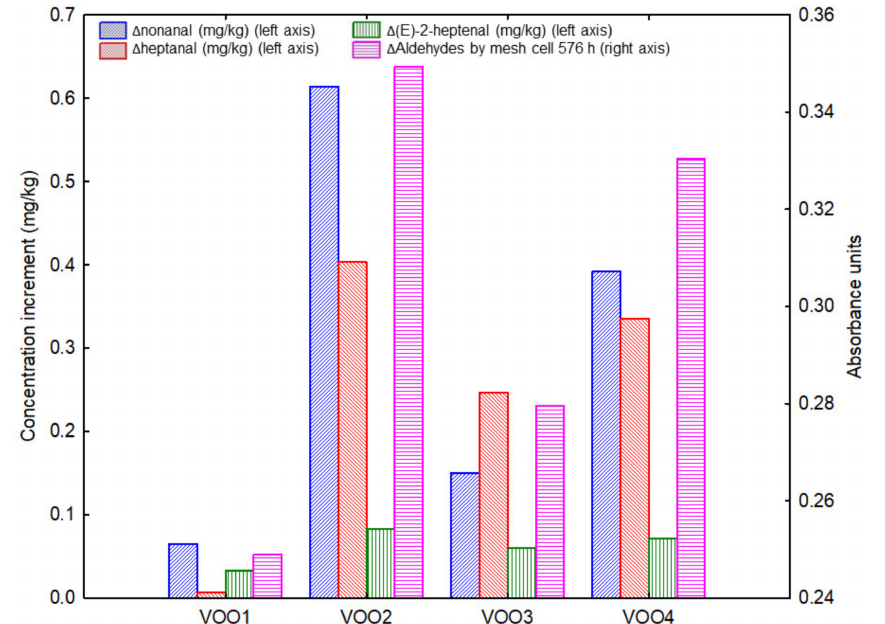
Figure 6. Double-y column graph in which the absorbance of the band assigned to aldehydes and the concentration increment ( ∆ ) of nonanal, heptanal and ( E )-2-heptenal are represented for the all studied virgin olive oils (VOOs) during the storage